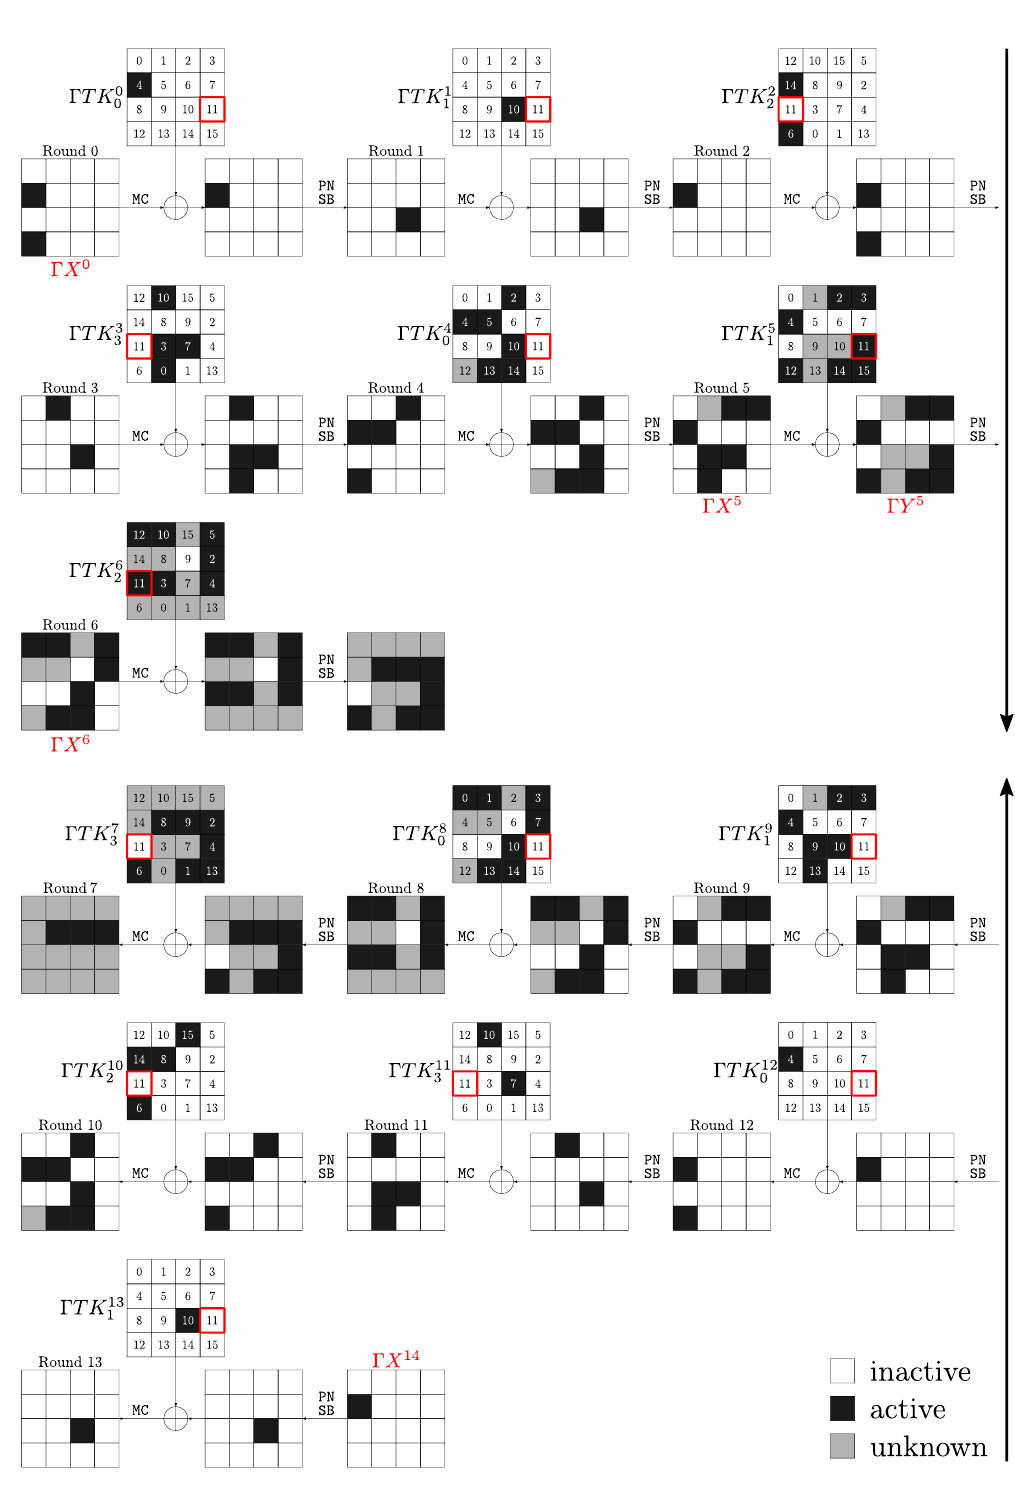
Figure 3: Related tweak zero-correlation of 14-round CRAFT in TK 0